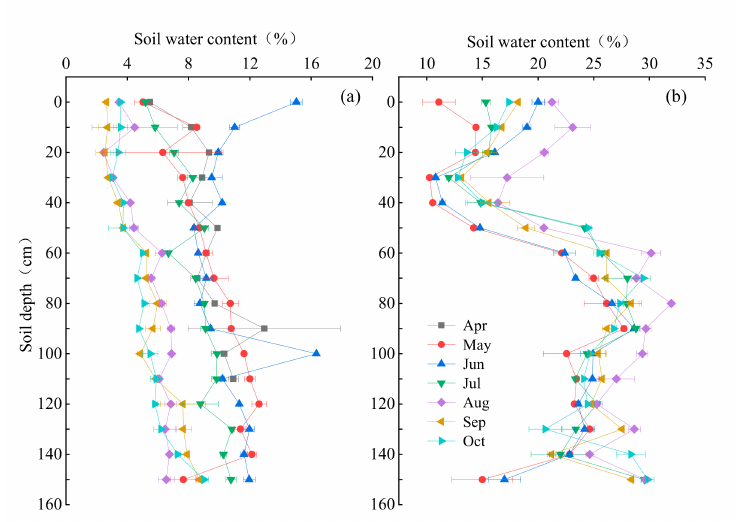
Figure 3. Variations of soil profile water content in the hillside ( a ) and floodplain ( b ) habitats (Mean ± SD, n =